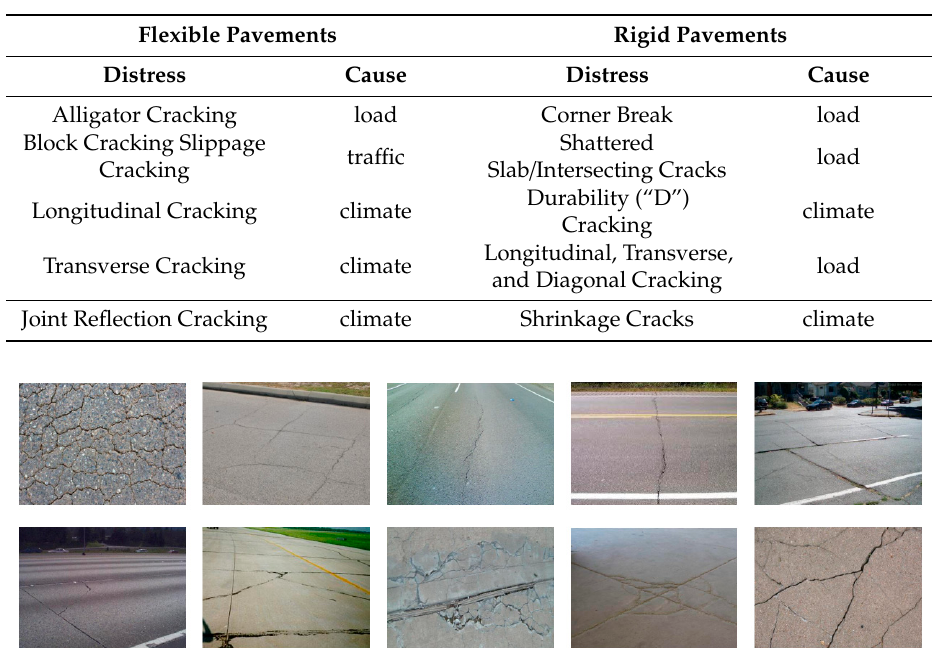
Figure 1. Some different crack types. In the top row (from the left to right: alligator cracking, block cracking, slippage cracking, longitudinal cracking, transverse cracking, and joint reflection cracking); on the bottom row (from the left to right: corner break, shattered slab/intersecting cracks, durability (“D”) cracking, longitudinal, transverse, and diagonal cracking, and shrinkage cracks).